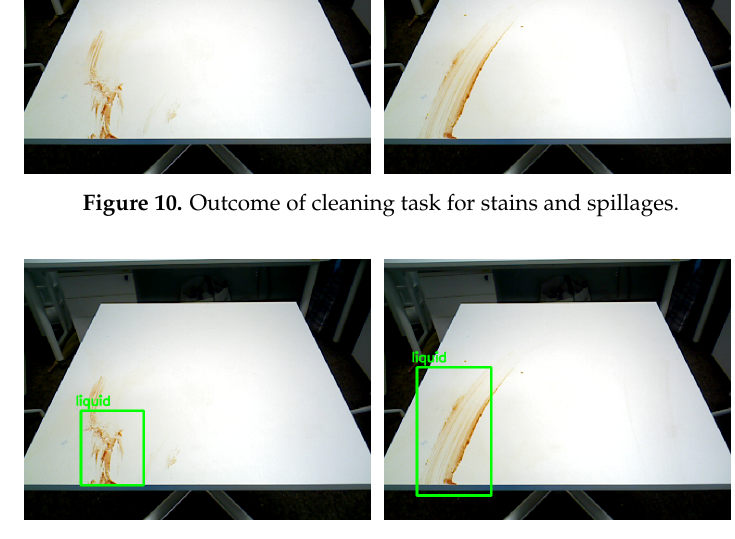
Figure 11. Cleanness inspection after execute the cleaning